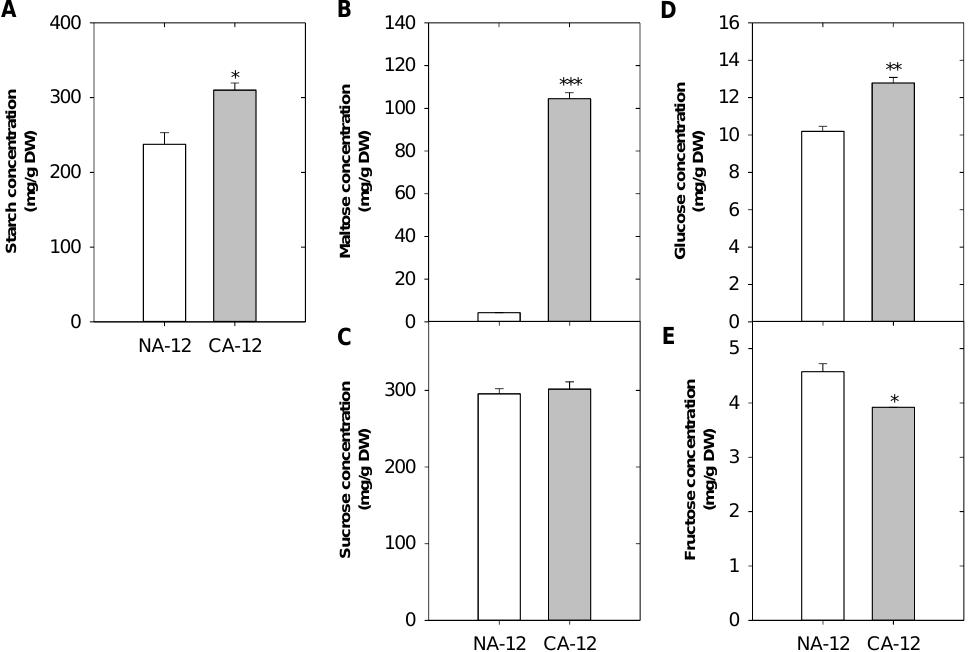
Figure 7. Concentration changes of starch and sugars in A. turgidum protonema of NA-12 and CA-12. Starch ( A ), Maltose ( B ), Sucrose ( C ), Glucose ( D ) and Fructose ( E ). The y -axis scales of each graph are different. CA-12, A. turgidum protonema were cold-acclimated at 4 ◦ C for 2 days and exposed to freezing until − 12 ◦ C; NA-12, A. turgidum protonema were non-acclimated at 25 ◦ C for 2 days and exposed to freezing until − 12 ◦ C. Data are means ± SD of three repeats (***, p < 0.001; **, p < 0.01; *, p < 0.05, Student t